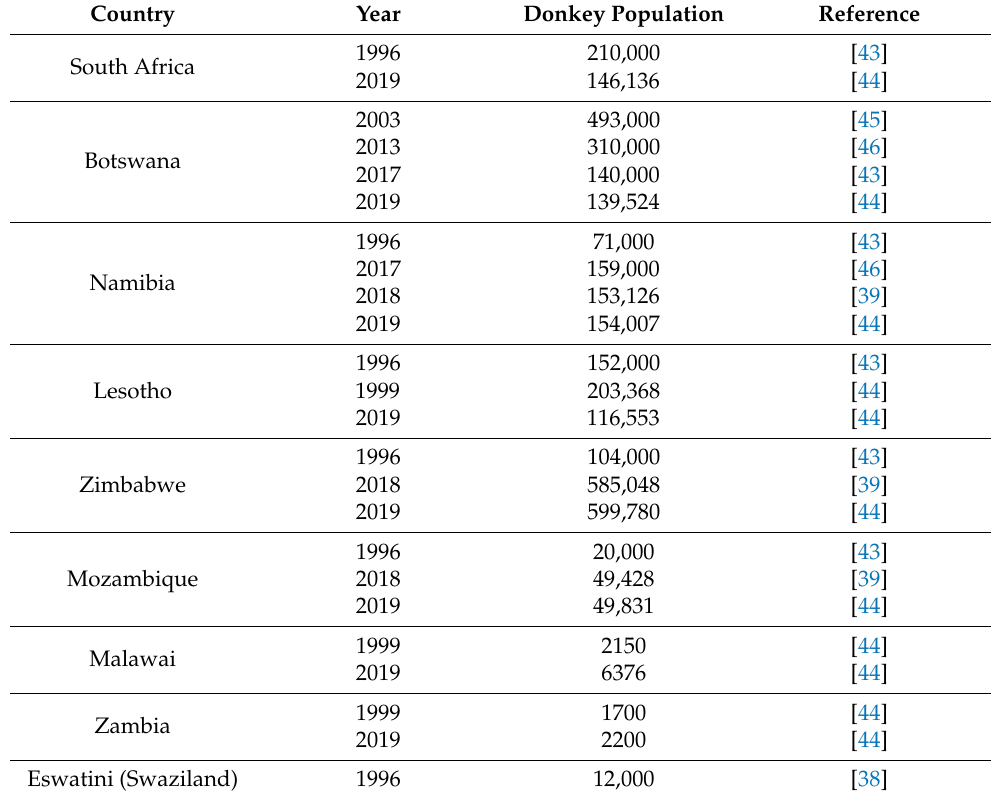
Table 1. Donkey populations in Southern